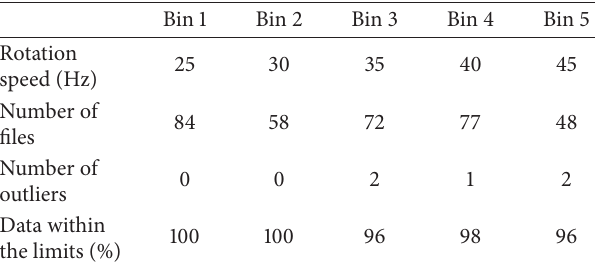
Table 3: Number of files for the baseline generation and effective- ness probed with an additional set of data.